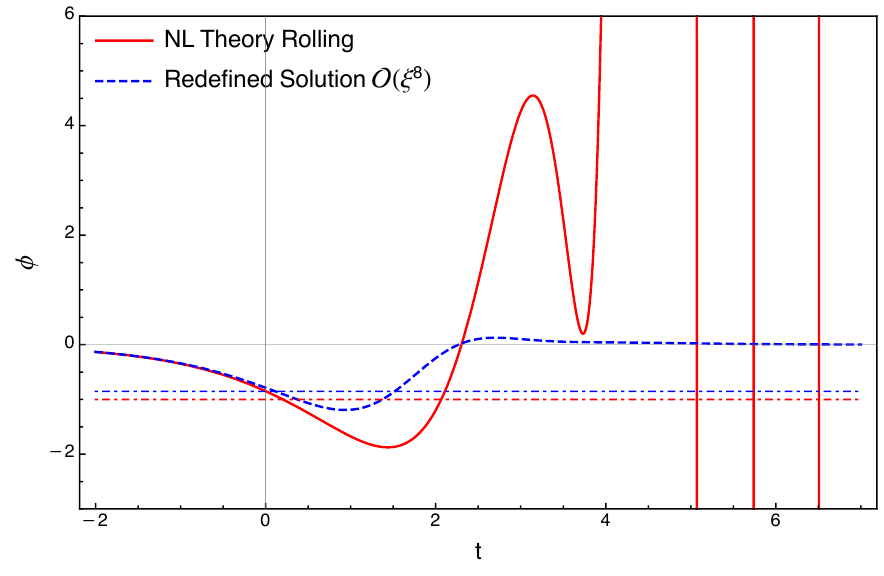
Figure 5 . Comparison between the solutions (4.4) (solid red) and (4.29) (dashed blue) when ξ = 0 . 35 . The color-coded dot-dash horizontal lines mark the stable vacua of their respective potentials. Notice their first pass through the minimum occur roughly at the same